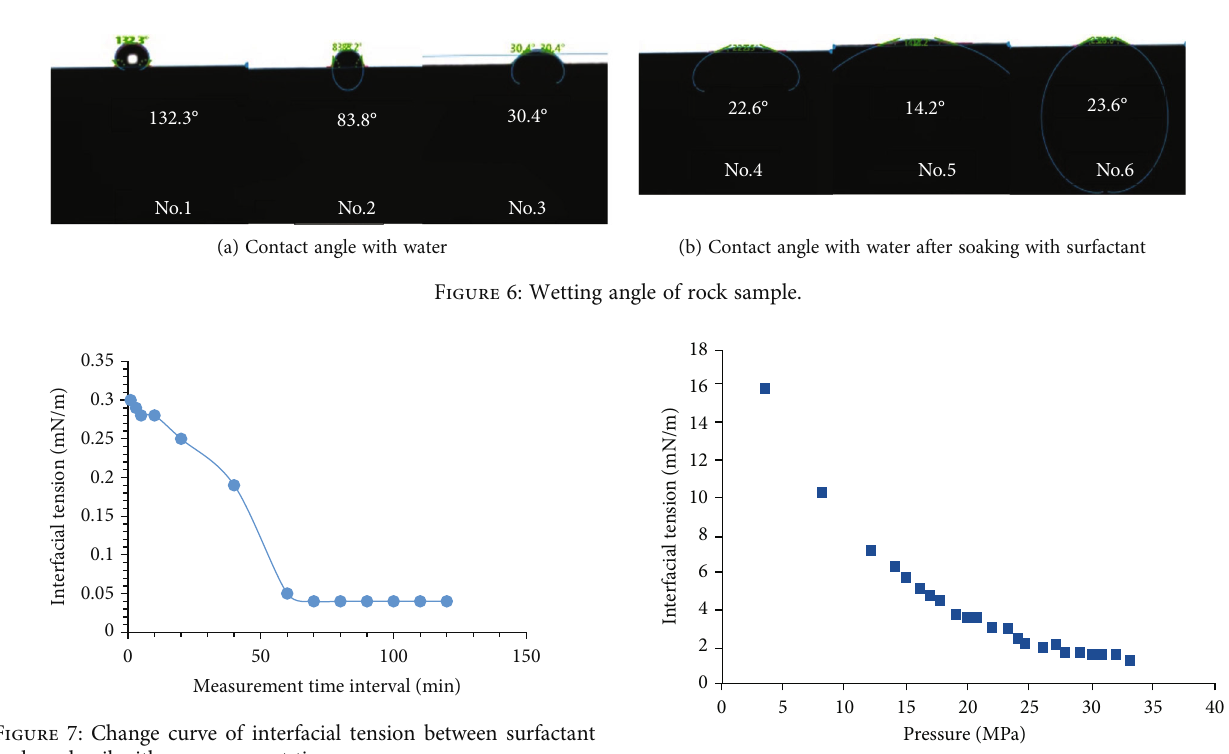
and crude oil 2